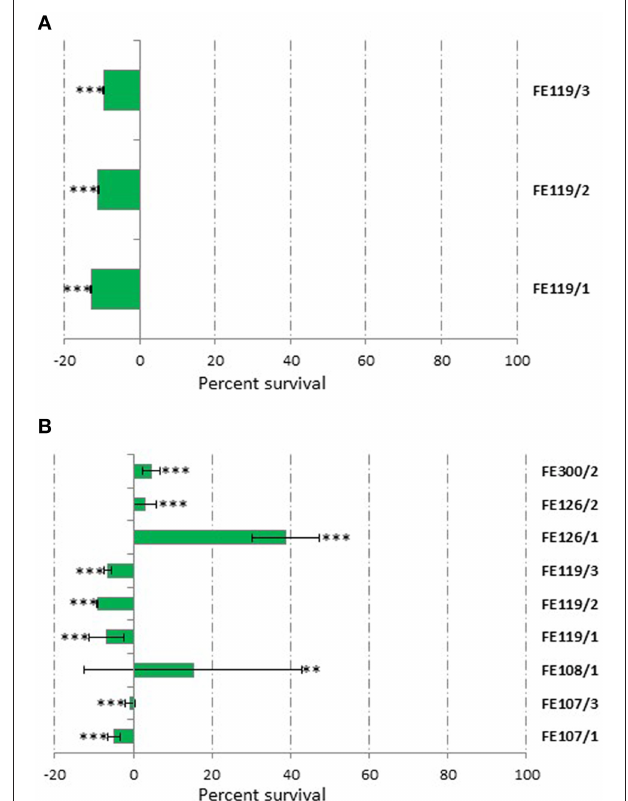
FIGURE 1 | Cytotoxicity Assay. Results from cytotoxic extracts using HepG2 cells for 24h (A) and MCF-7 cells for 72h (B) compared to controls. Results are expressed as percent survival after 24 and 72h exposure respectively ( n = 9, data represent means for three biological and nine technical triplicates). FE119 corresponds to Ostreopsis ovata , FE107 to Alexandrium tamutum, FE126 to Alexandrium minutum , FE108 to Alexandrium andersoni, and FE300 to Coscinodiscus actinocyclus (/1, /2, and /3 correspond to Normal, N-starved or P-starved extracts, respectively; ** for p < 0.01 and *** for p < 0.001, Student’s t